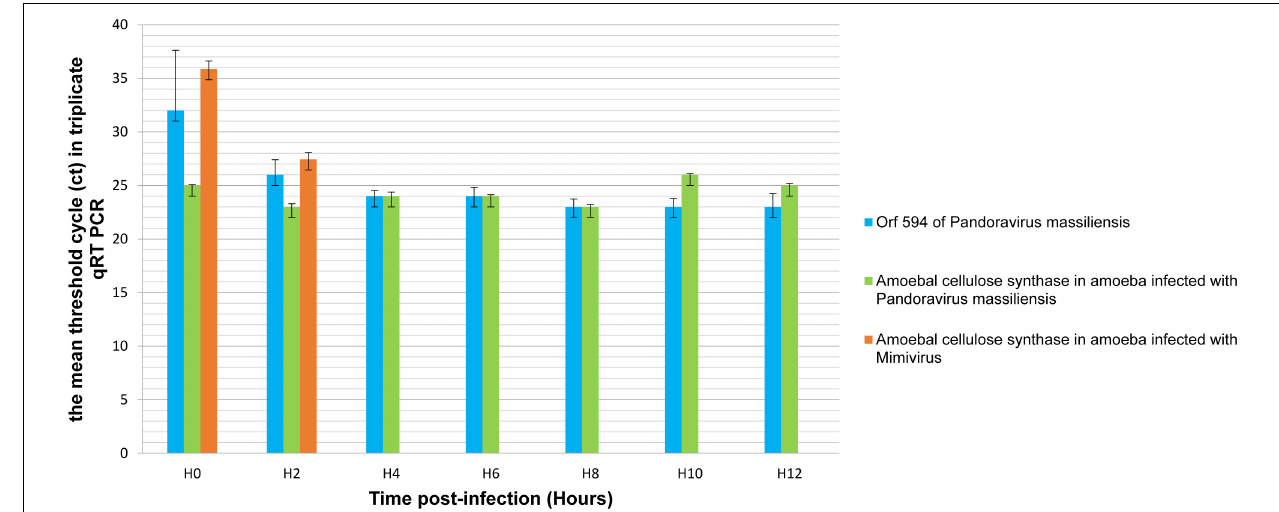
FIGURE 10 | Representation of the mean threshold cycle (Ct) of triplicate qRT PCR on the RNA of P. massiliensis by targeting the predicted gene of the cellulose synthase (ORF594) and on RNA of A. castellanii infected once with P. massiliensis and a second time with Mimivirus by targeting the amoebal gene of the cellulose synthase, according to the time post-infection from 0 to 12 h